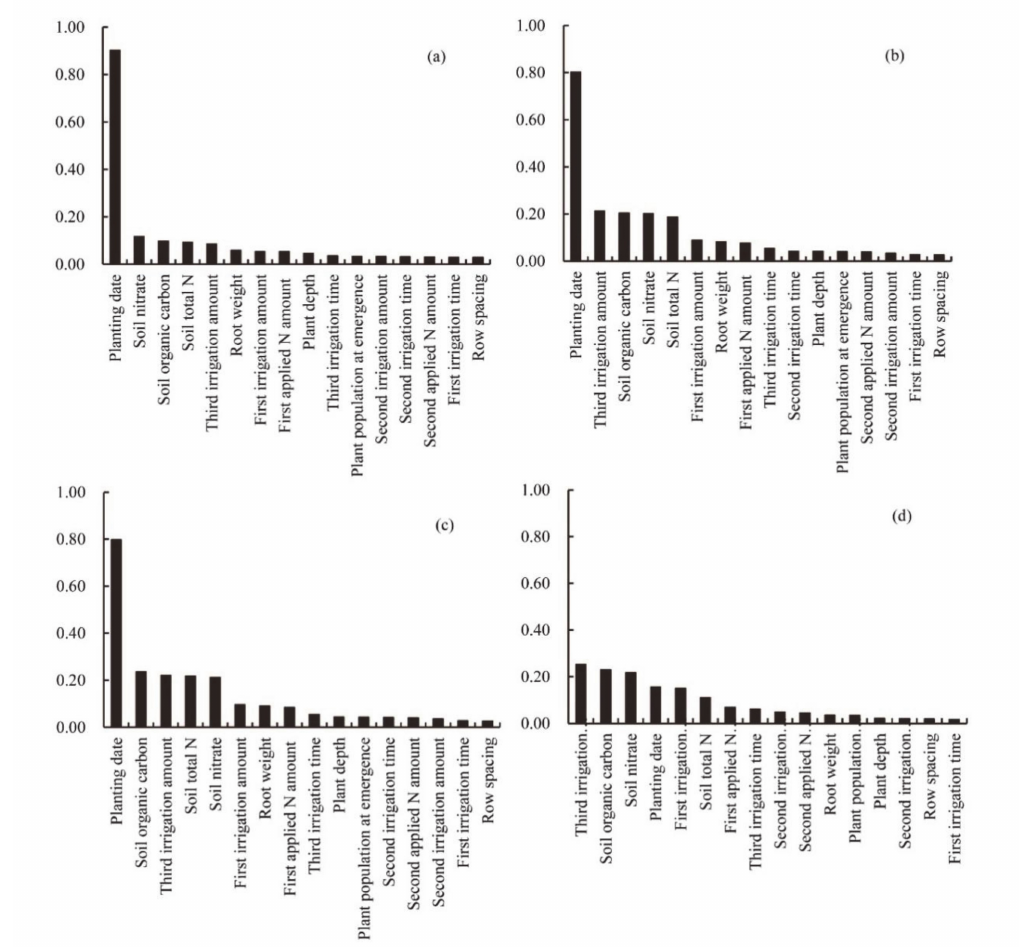
Figure 4. Extended fourier amplitude sensitivity test (EFAST) sensitivity analysis results for selecting adjusted variables using LAI as the state variable. Sensitivity of ( a ) GPC; ( b ) LAI at the booting growth stage; ( c ) LAI at anthesis growth stage; ( d ) LAI at the grain filling growth stage to soil and field management